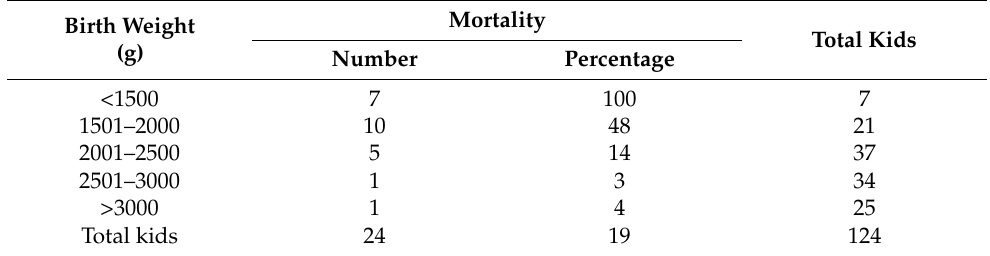
Table 1. Frequencies of kid mortality according to the weight at birth, in a mixed rearing system.